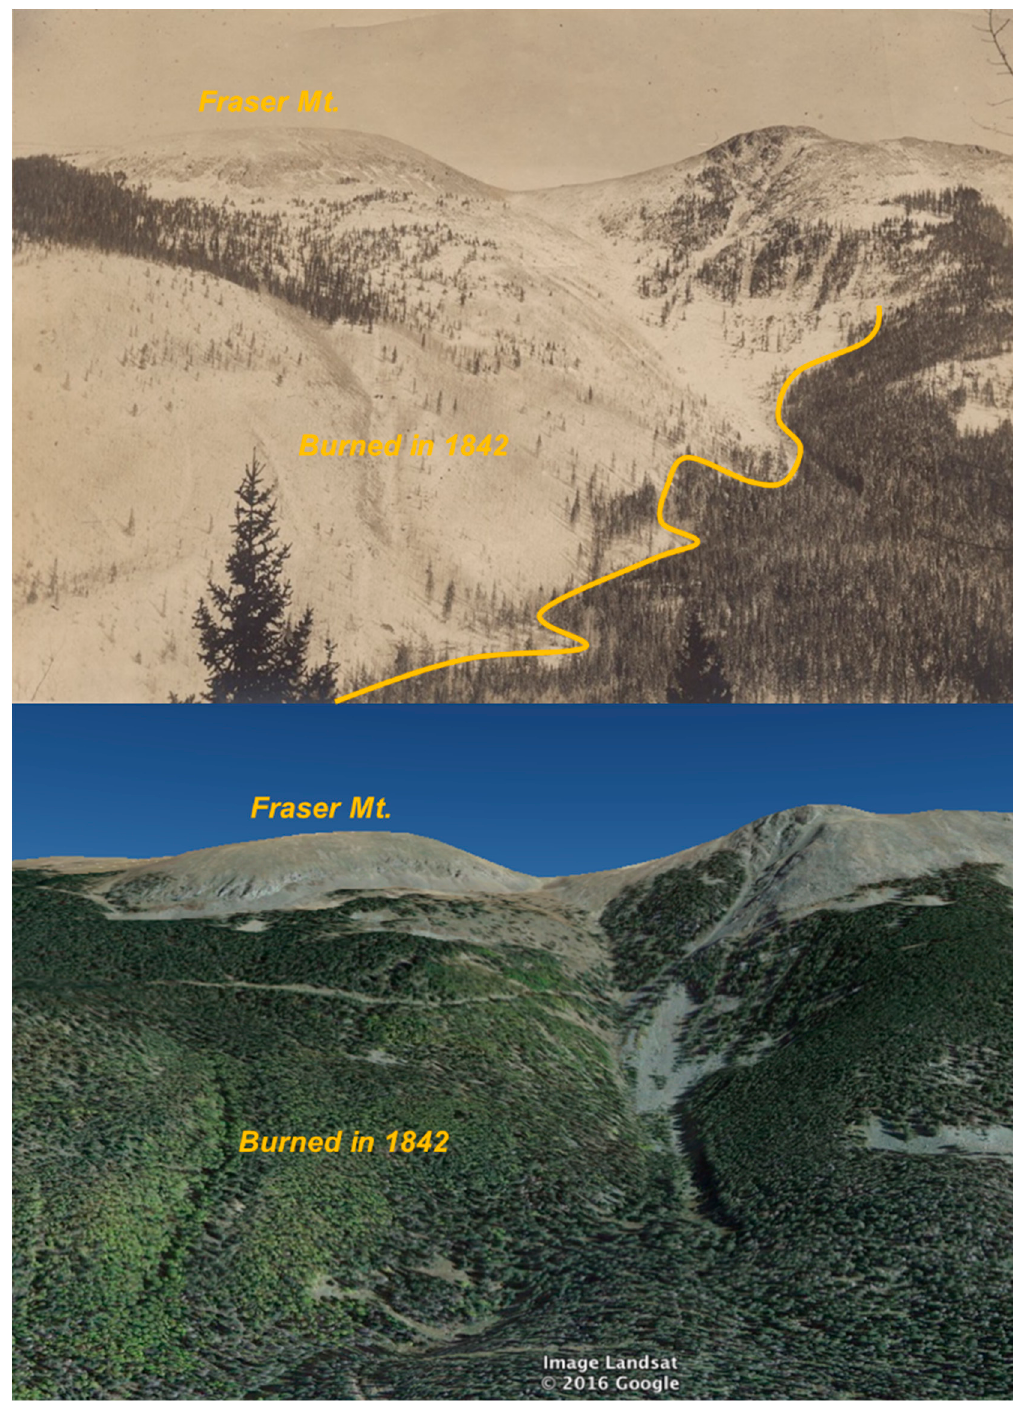
Figure 9. Repeat images looking east from 1903 ( top ) and 2016 ( bottom ) of the upper Rio Hondo drainage that burned in a high-severity fire in 1842. The visible burned area includes age-structure plot RHD. The sketched burn boundary line (top) is estimated to be the southern-most extent of this high-severity fire patch (See Figure 7). The conifer forest to the south (top photo, bottom right) had trees dating to the 1650s (plot RHG) and did not burn in the 1842 high-severity patch. Fraser Mountain is the dome at image left. The historical image is courtesy of Mickey Blake and Taos Ski Valley Inc., Image no. TSV-1042A. The 2016 image was from Google Earth. See Figure 7 for the photo location and direction.